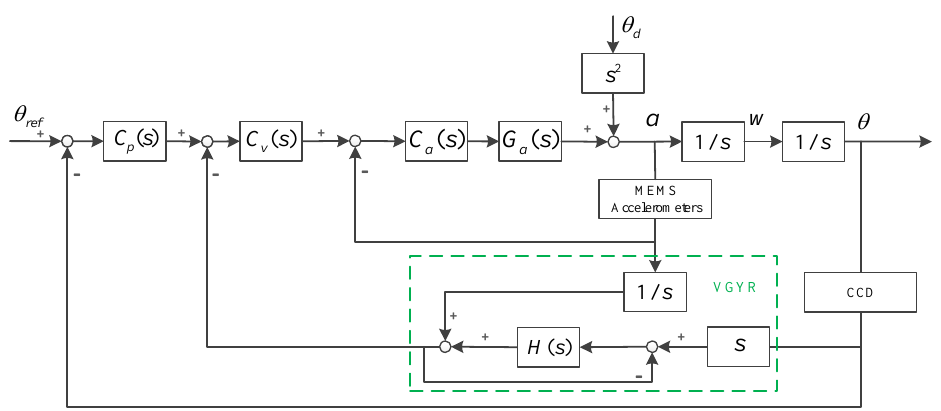
Figure 5. Schematic diagram of virtual multi-loop feedback control system.